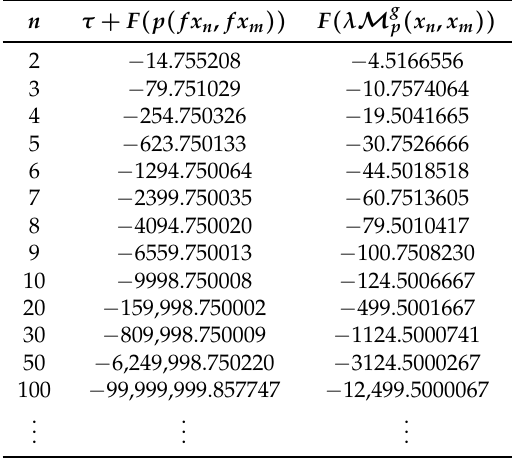
Table 1. The numerical comparison of L.H.S. and R.H.S. of